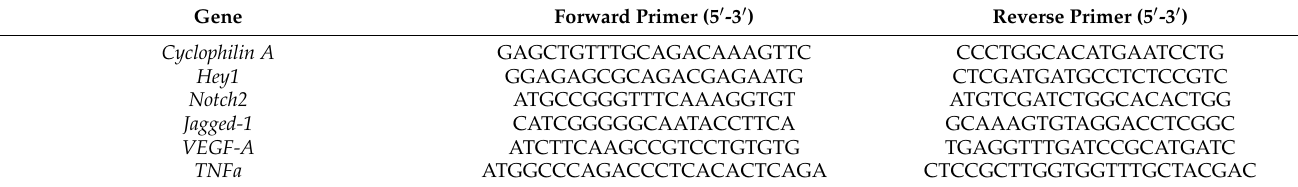
Table 1. Primers used in this